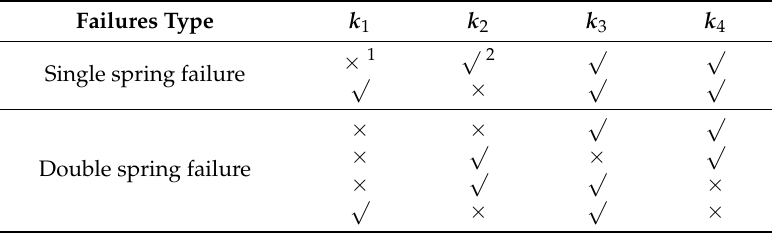
Table 2. Types of spring